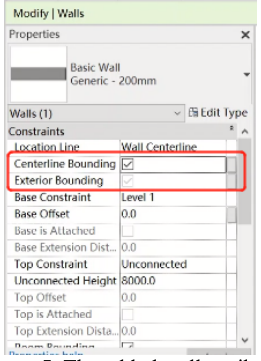
Figure 5. The added wall attributes